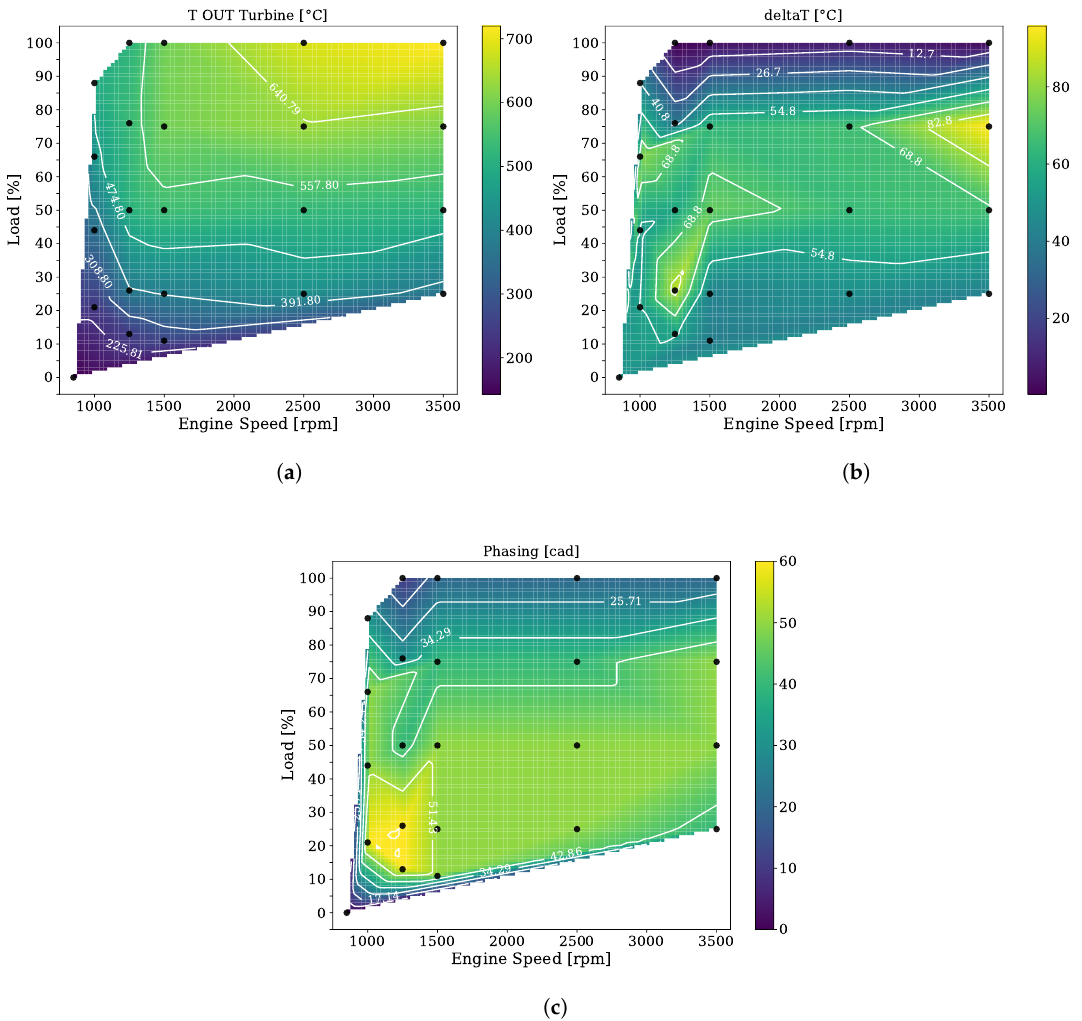
Figure 8. Temperature at turbine outlet and valve phasing maps for Case 3. ( a ) Temperature map at turbine outlet.; ( b ) Temperature difference map at turbine outlet respect to the baseline case; ( c ) Valve phasing